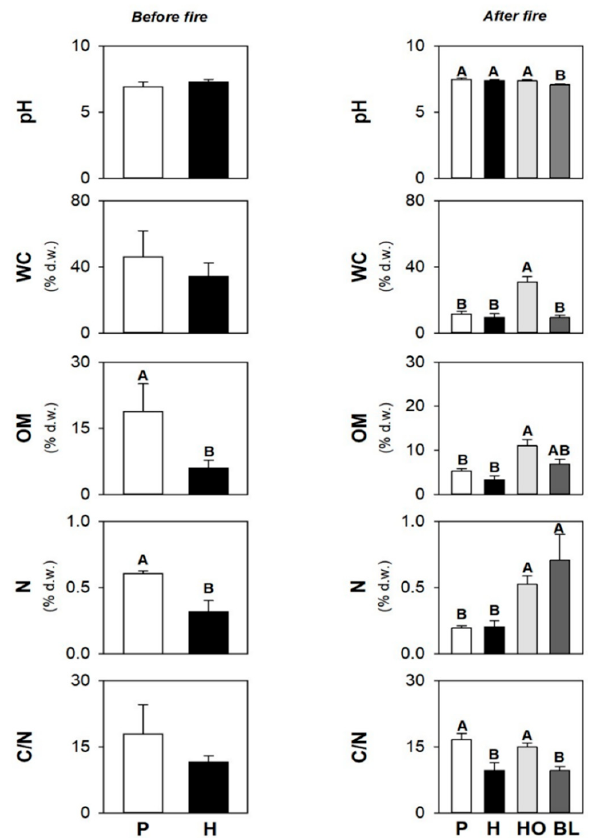
Figure 1. Mean values (±s.e.) of pH, water content (WC), organic matter content (OM), N concentration, and C/N ratio of soil sampled under pine (P) and herbs (H) before the fire and under the pine (P), herbs (H), holm oak (HO), and black locust (BL) after the fire. Different uppercase letters indicate statistically significant differences ( p < 0.05) among different vegetation types in soils collected before and after the fire.